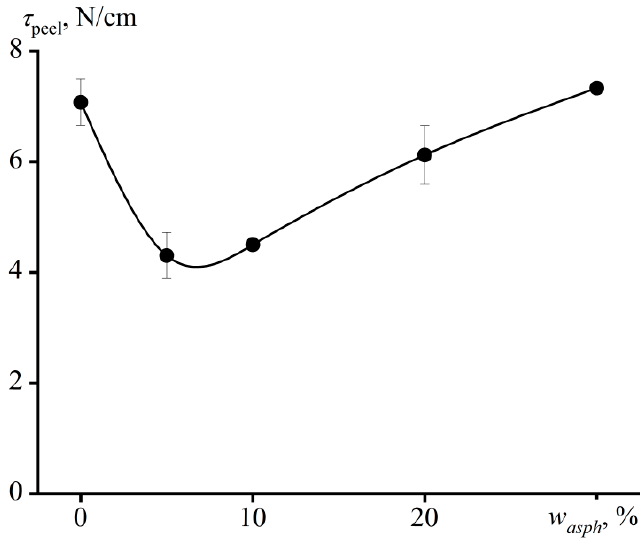
Figure 9. The dependence of peel strength on the asphaltene content in adhesives.